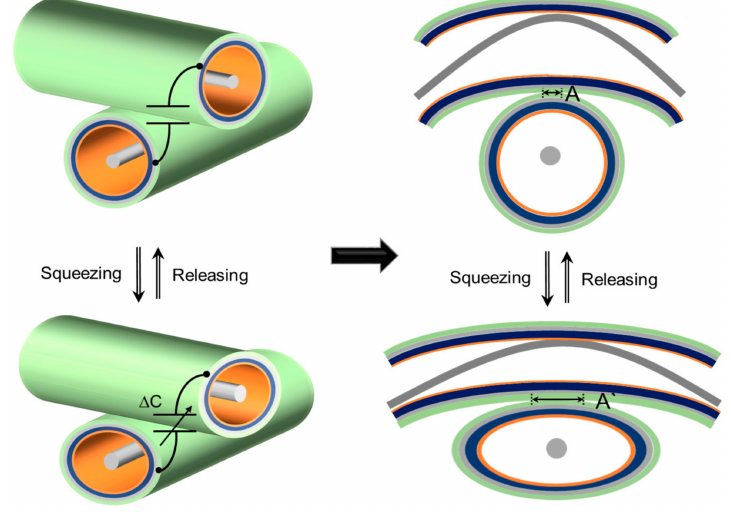
Figure 3. Magnified view and cross-sectional view of device explaining capacitive sensor